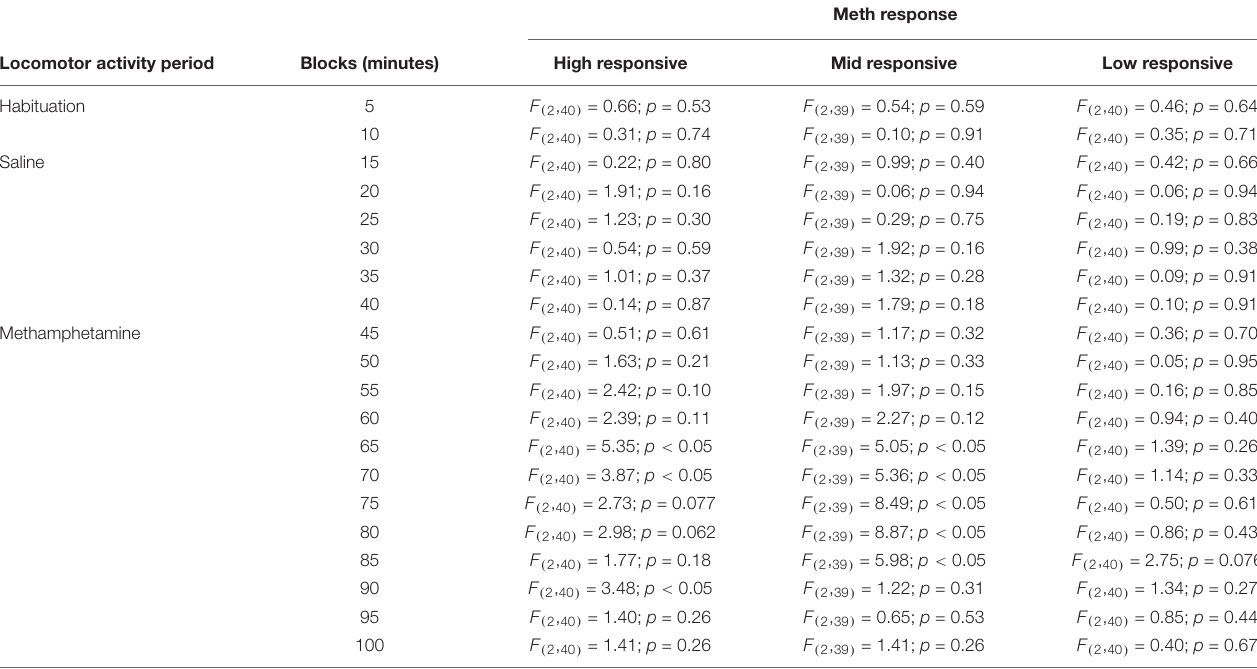
TABLE 5 | One-way ANOVA for locomotor cross-sensitization